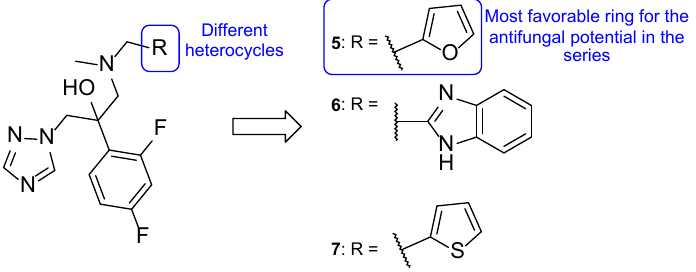
Figure 9. Chemical structures of compounds 5 , 6 , and 7 , novel triazole agents derived from iodicon- azole ( 4 ), and respective SAR [57].